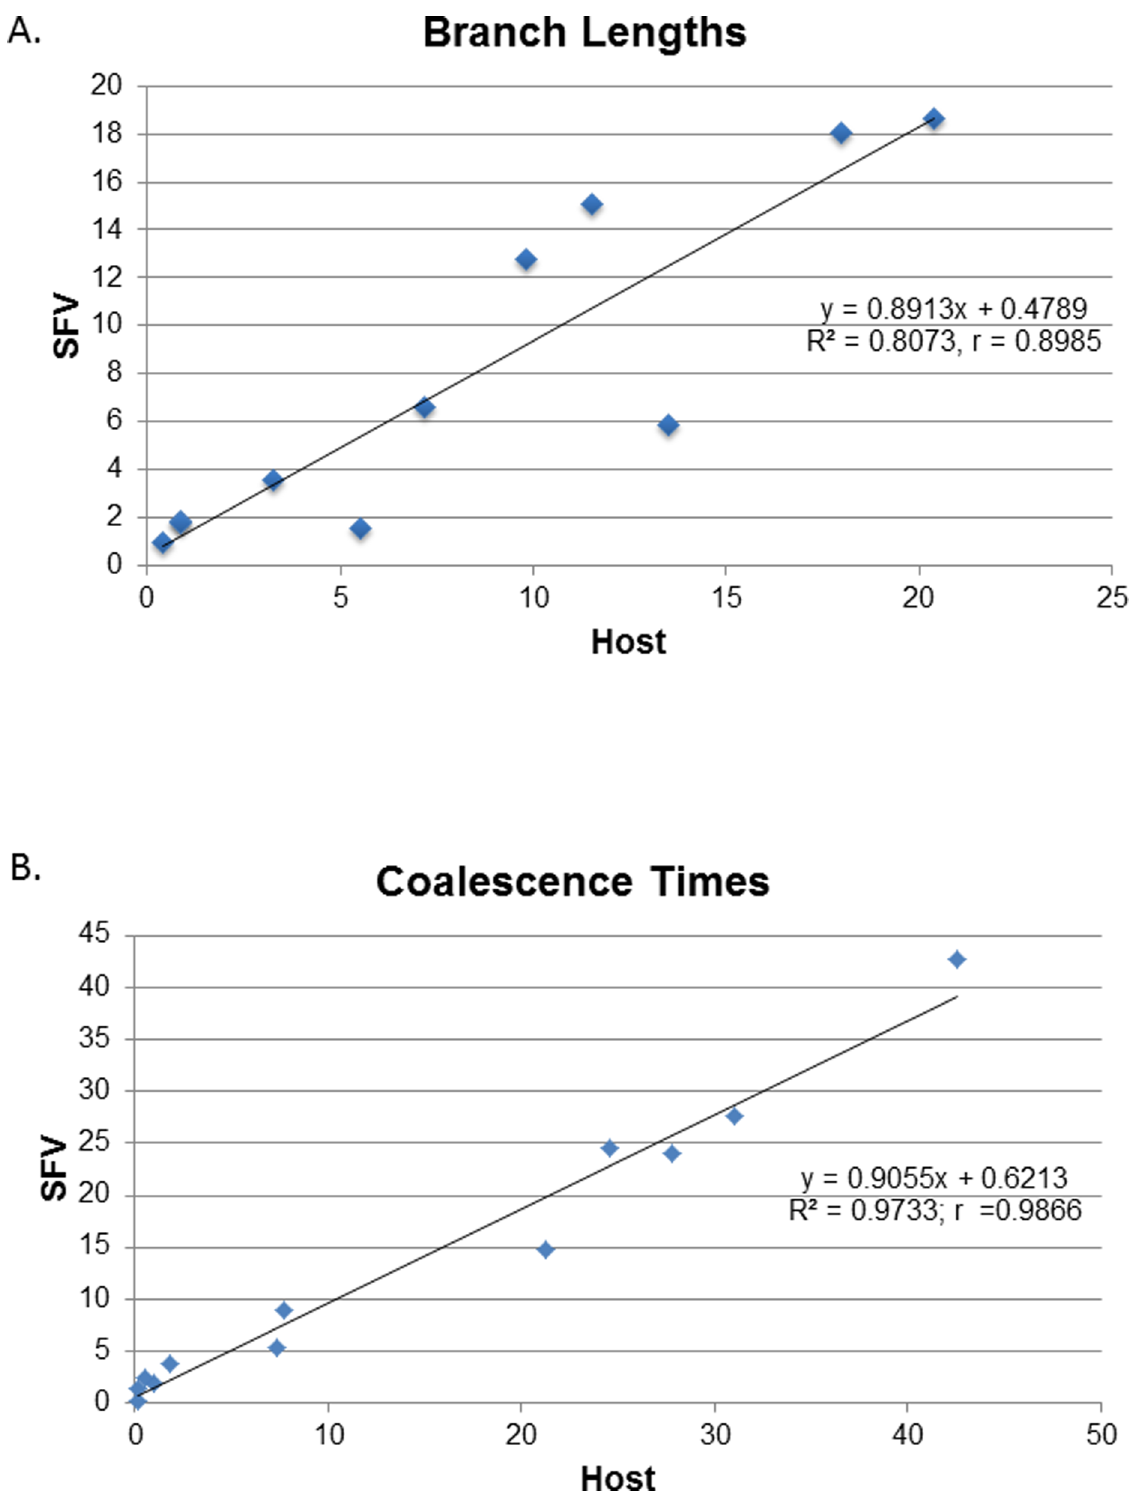
Figure 5. Correlation of ( A ) branch lengths (substitutions per site) and ( B ) coalescence times (genetic distances) of primate cytochrome B and SFV polymerase ( pol ) Bayesian-inferred phylogenetic trees. doi:10.1371/journal.pone.0067568.g005 The third host switch was inferred to have occurred from an SFV- infected C. apella to a C. albifrons (F70) (Fig. 4). We also found strong linear relationships between the branch lengths (r = 0.8985)